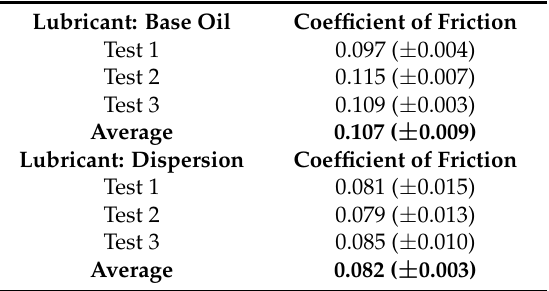
Table 1. Average values and standard deviations (in brackets) of the coefficient of friction across three tests.